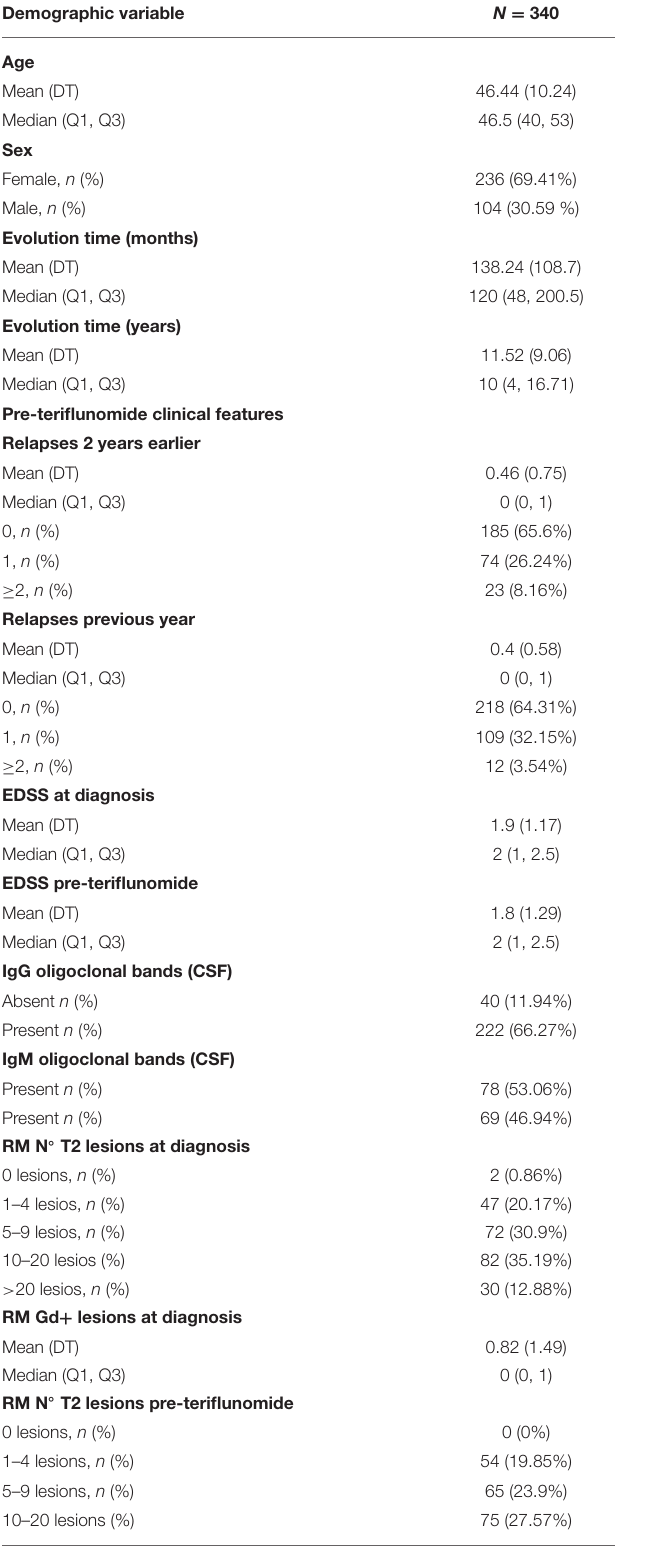
TABLE 1 | Baseline characteristics of the studied